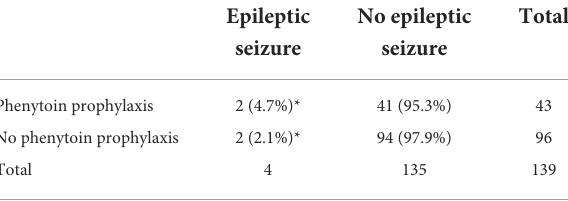
TABLE 2 Incidence of epileptic seizures with unknown cause in both